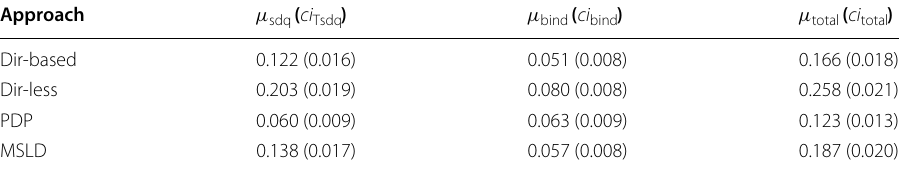
Table 3 Comparison of SD Protocol Latency (s)